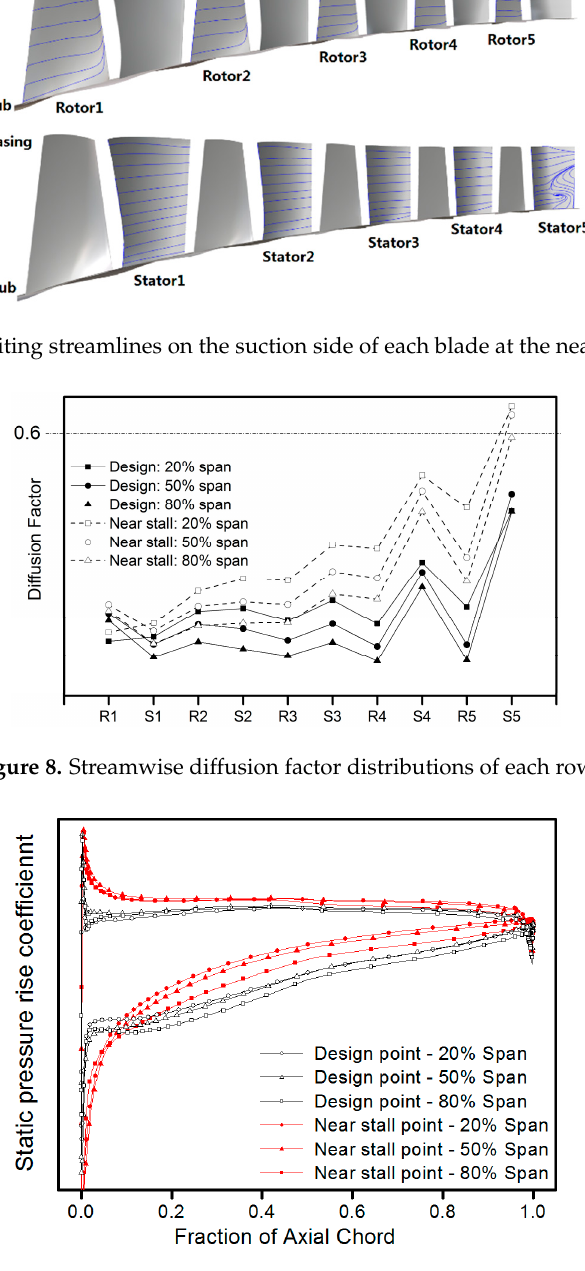
Figure 9. Surface static pressure rise coefficient distributions at the 20%, 50% and 80% spans of stator 5.